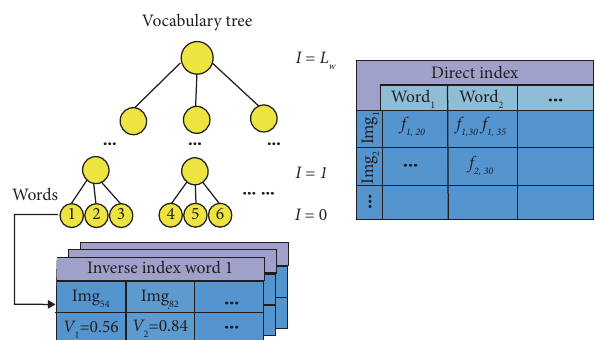
Figure 16: BoW schematic diagram.